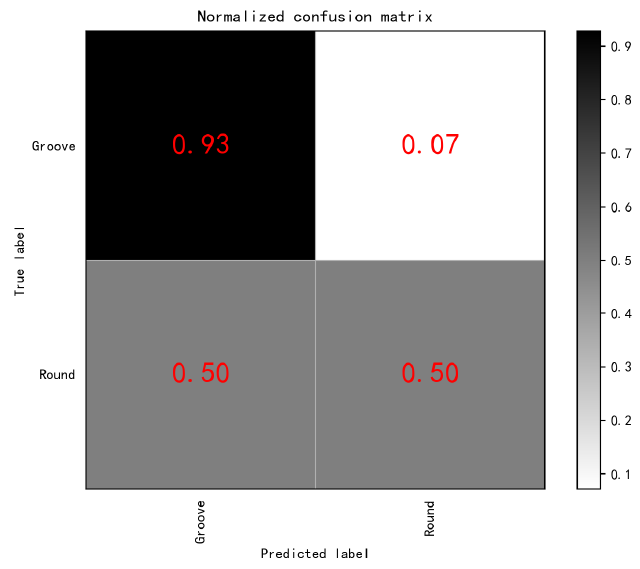
Figure 11. KNN for Normalized confusion matrix.